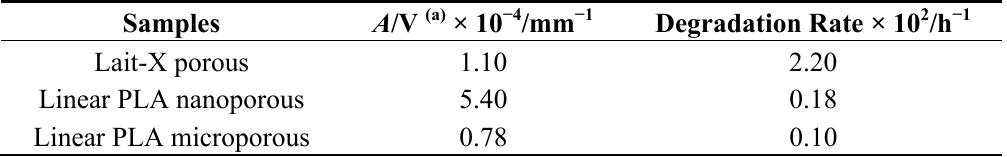
Table 2. Surface area to volume ratio ( A / V ) and degradation rate obtained from the initial slope in Figure